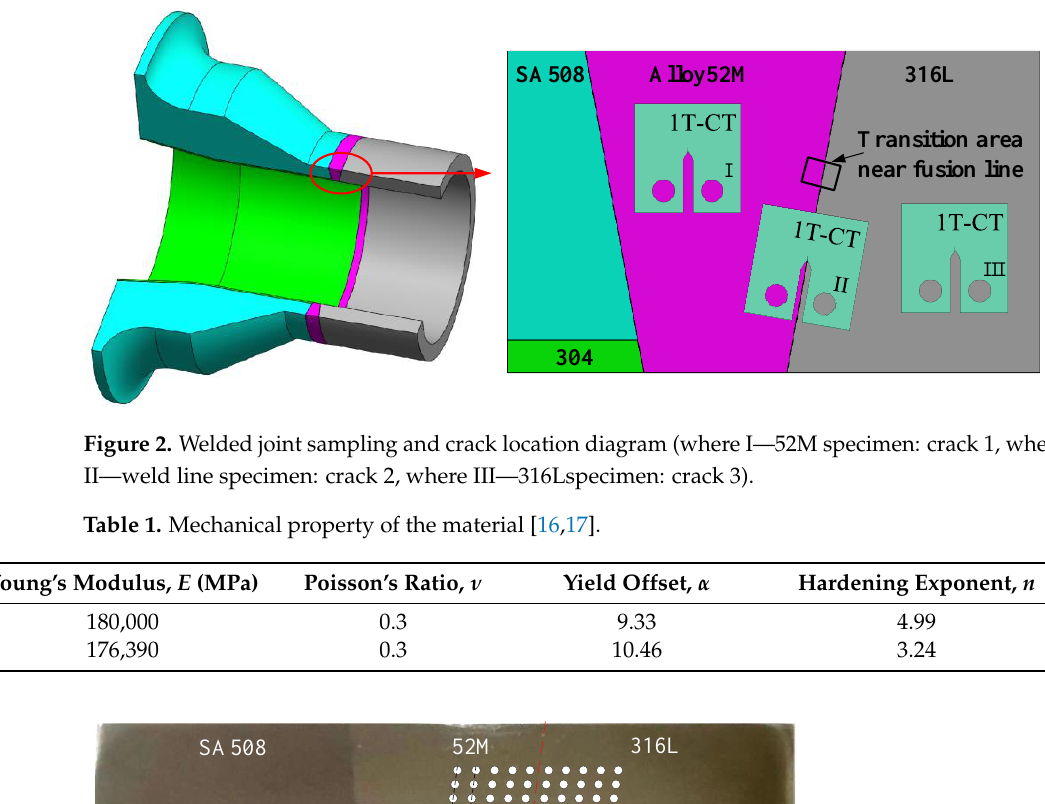
Figure 2. Welded joint sampling and crack location diagram (where I — 52M specimen: crack 1 ，